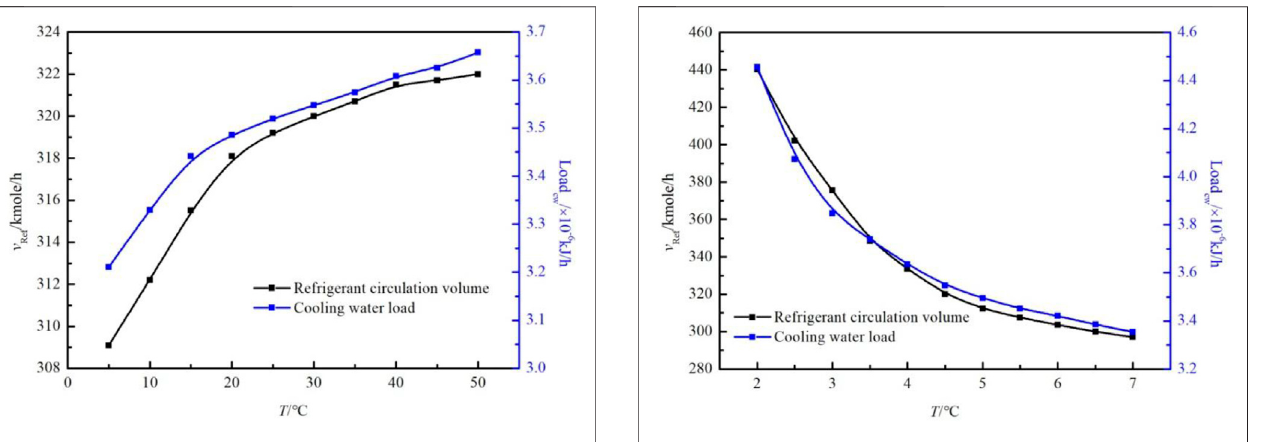
FIGURE 6 | In fl uence of natural gas pressure on freezing mixture circulation capacity and cooling water load of the system.